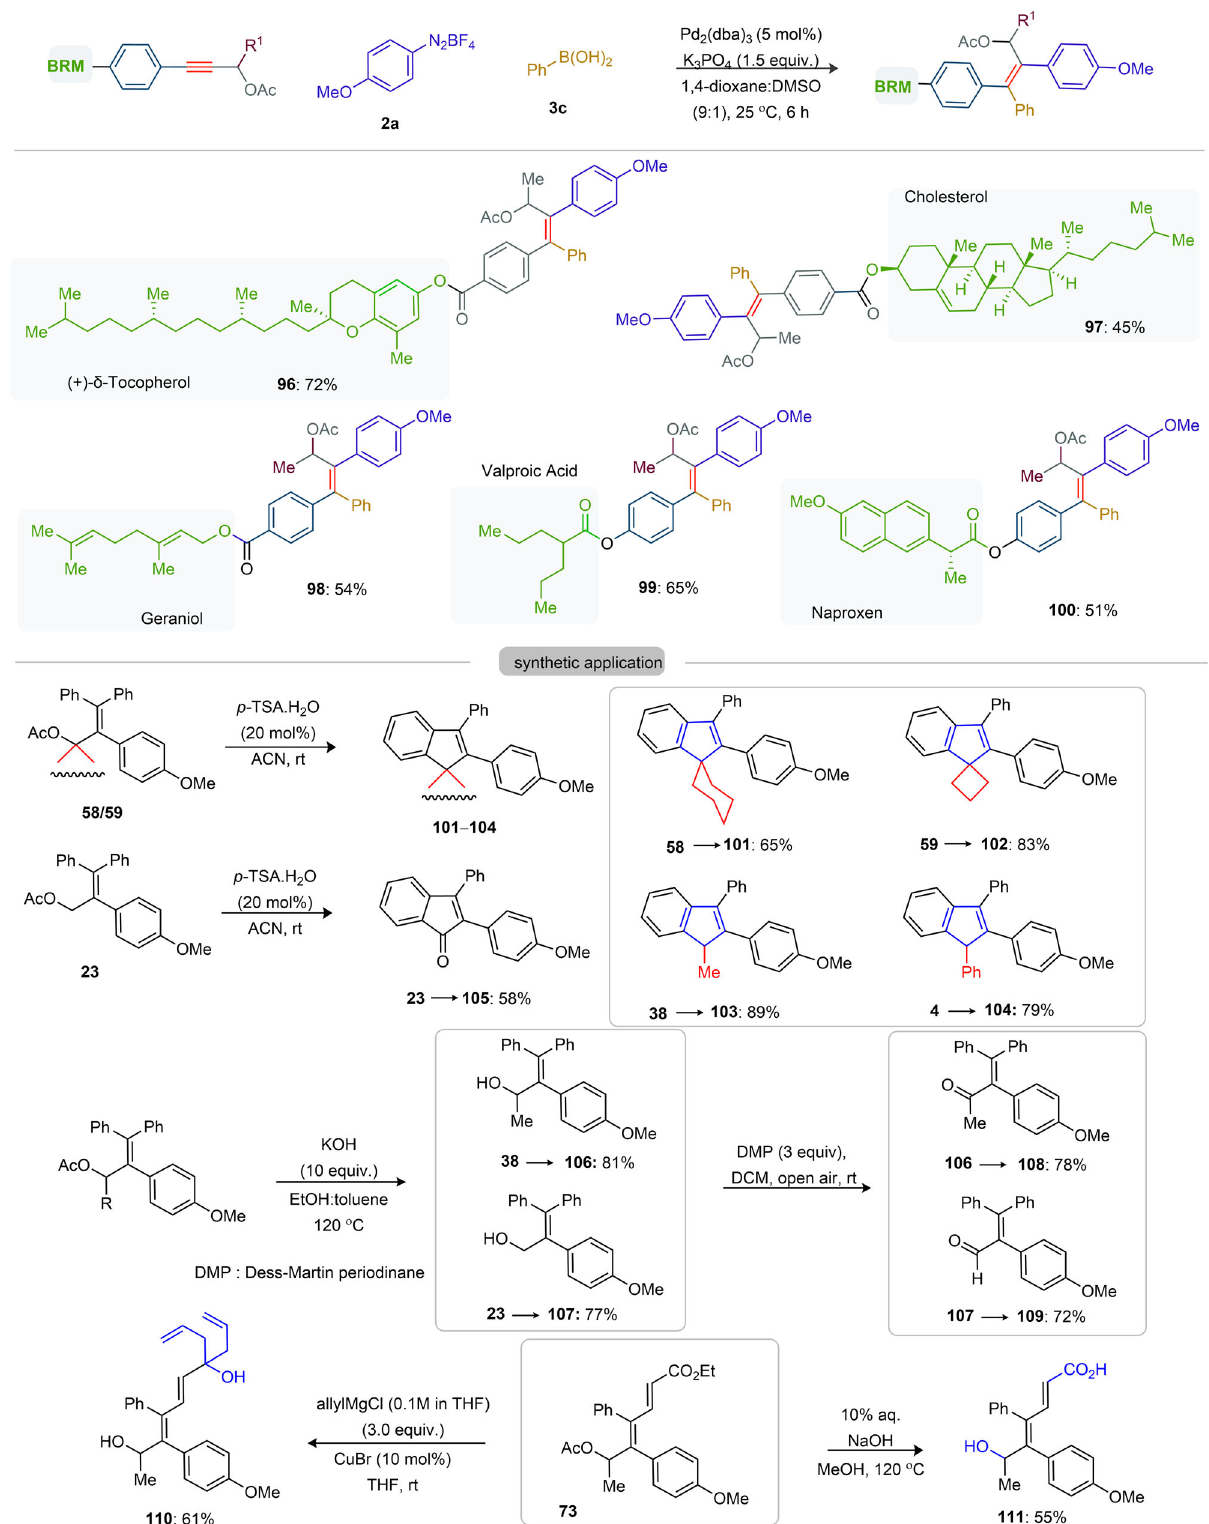
Fig. 5 Scope of diarylation of biologically relevant motif coupled alkynes and synthetic applications. All reactions are carried out on a 0.2 mmol scale. All the compounds are isolated as a single isomer, unless otherwise stated. P -TSA p -tolylsulfonic acid, DMP Dess – Martin